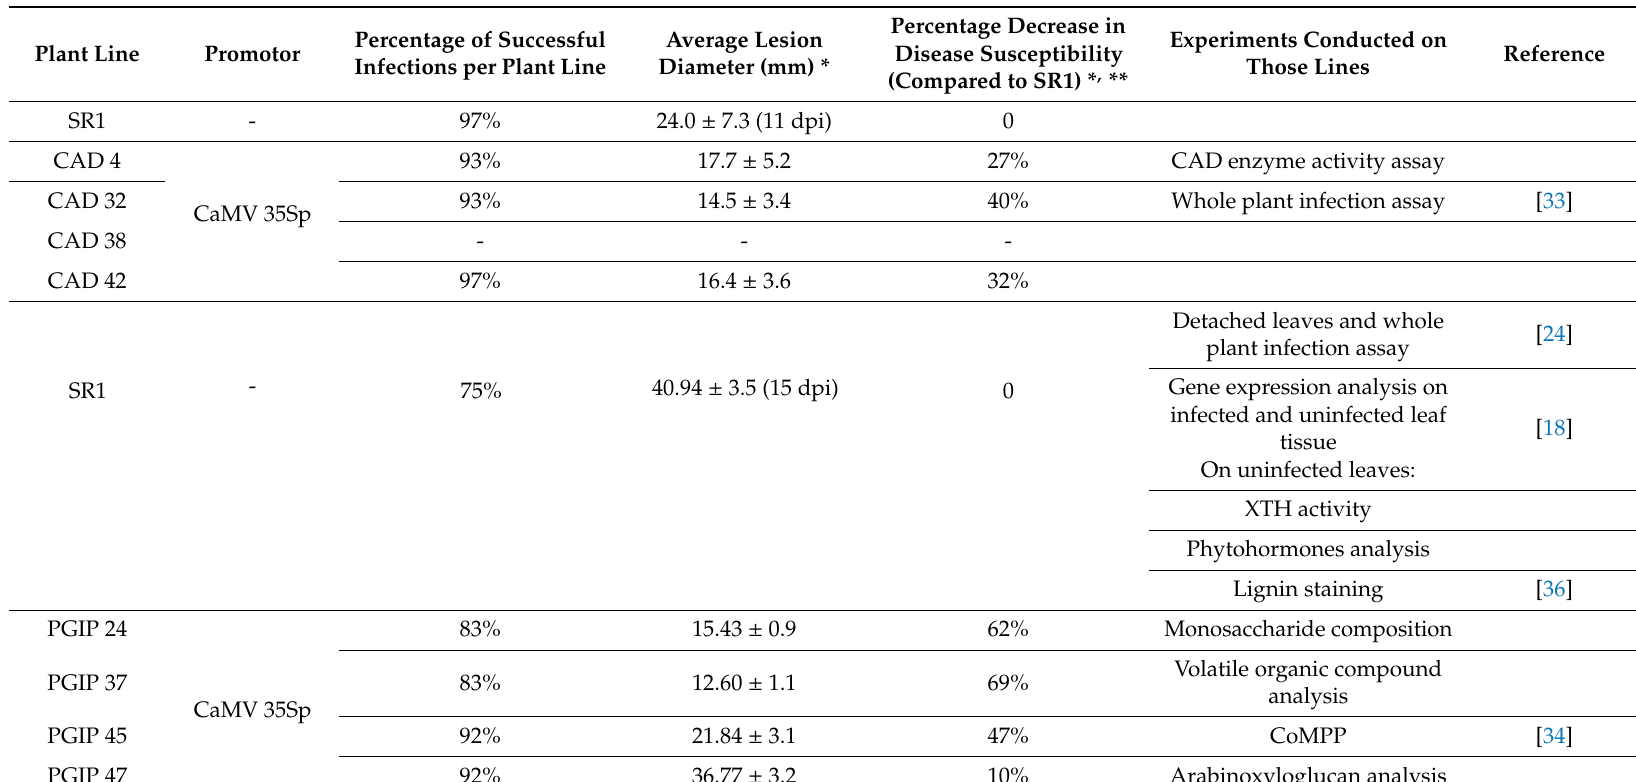
Table 1. Table summarizing known information on the transgenic lines used in this